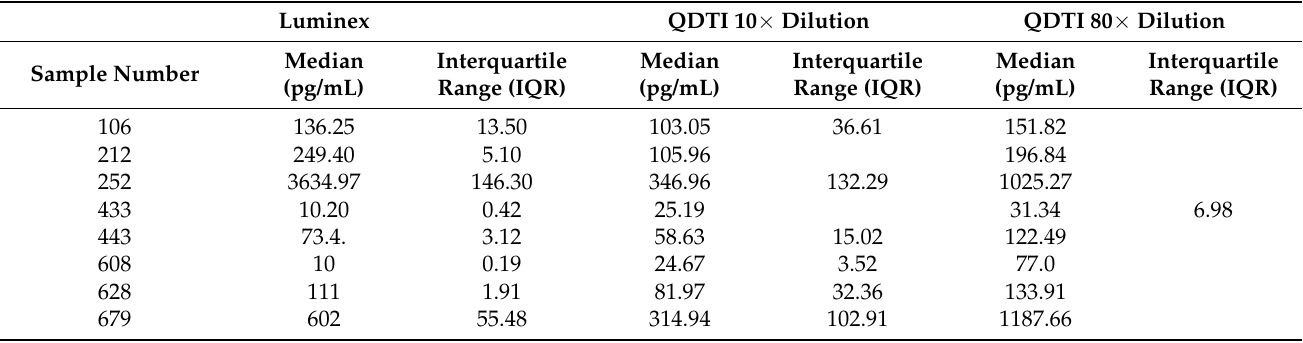
Figure 5. Luminex (red), QDTI10x (green), and QDTI80x (blue). ( A ) ROC for patients admitted to the ICU. ( B ) ROC for patients requiring intubation. Table 5. IL-6 mean concentrations by Luminex, QDTI10x, and QDTI80x for patients requiring mechanical